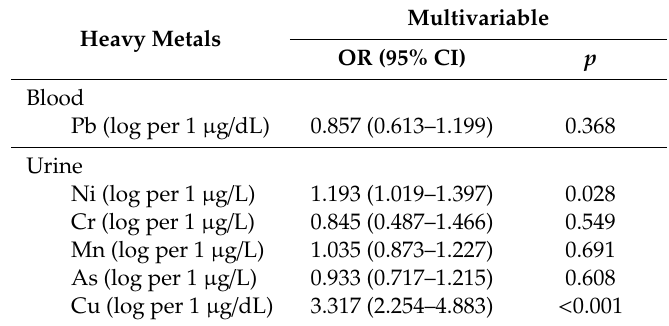
Table 2. Association of heavy metals with MetS using multivariable logistic regression